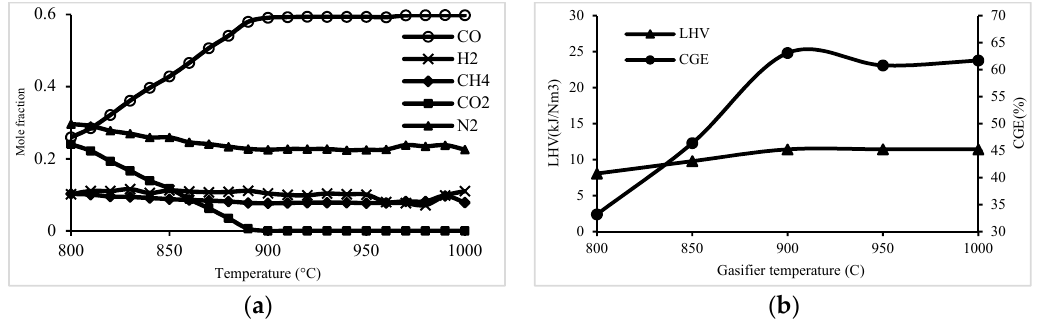
Figure 2. Effect of the gasifier temperature on ( a ) syngas composition and ( b ) LHV and cold gas efficiency (CGE).